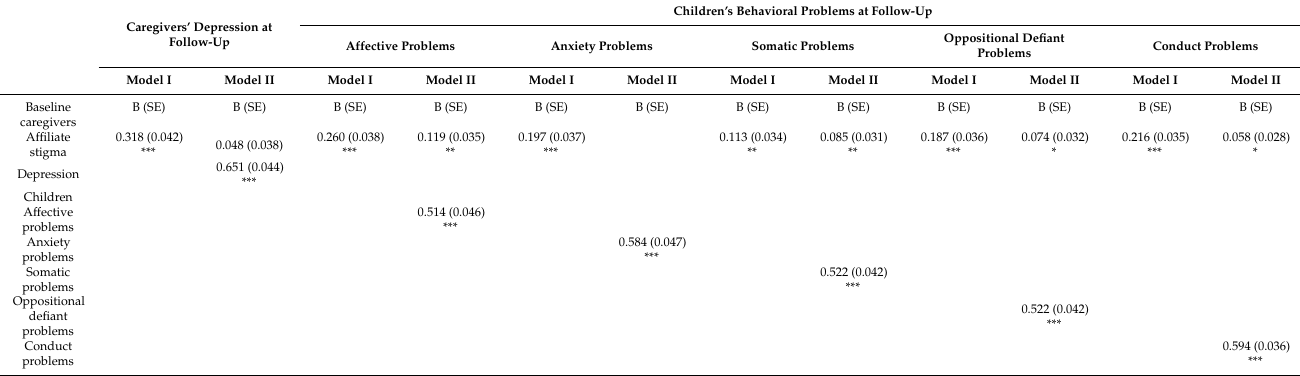
Table 3. Associations of caregivers’ affiliate stigma at baseline with caregivers’ depression and children’s behavioral problems at follow-up: forward stepwise multiple regression analysis a